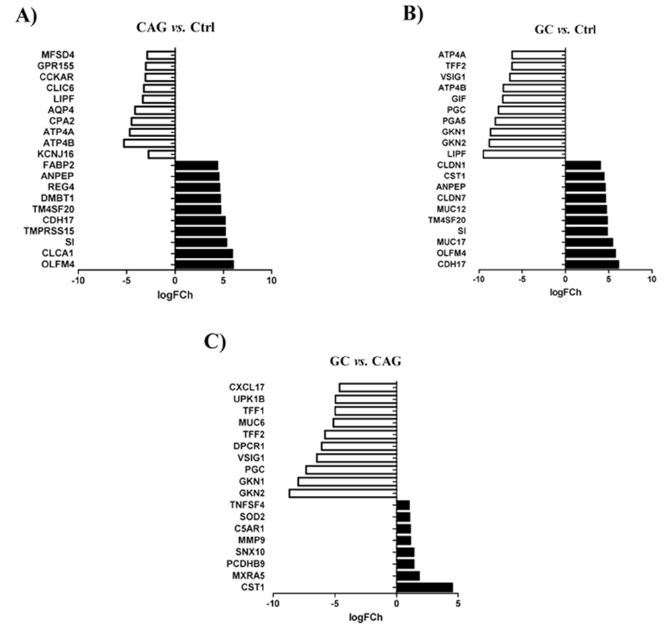
Figure 1. Top 10 differentially expressed genes. ( A ) Chronic atrophic gastritis vs. control group (CAG vs. Ctrl), ( B ) gastric cancer vs. control group (GC vs. Ctrl), and ( C ) gastric cancer vs. chronic atrophic gastritis (GC vs. CAG). Subexpressed genes (white bars), overexpressed genes (black bars).